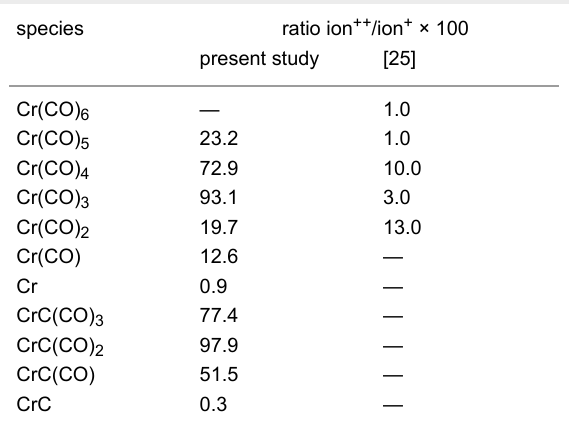
Table 3: Ratio of doubly and singly charged